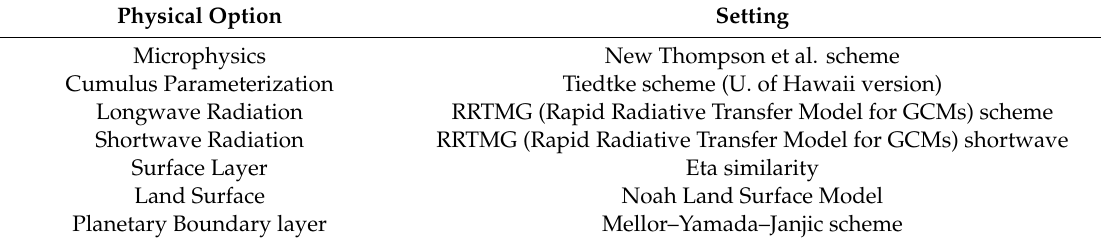
Table 3. Configuration Options for the WRF-Chem Model for Dust.